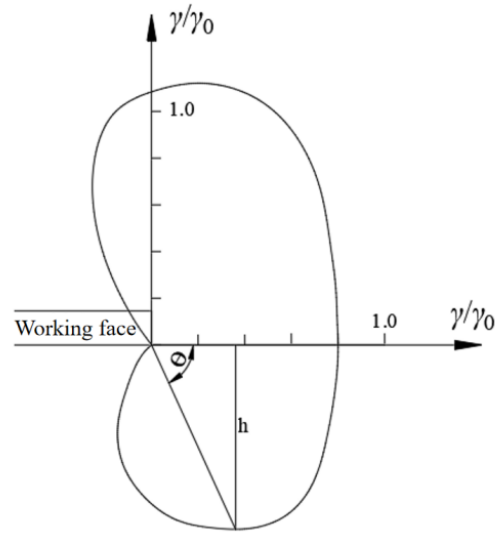
Figure 9. Surrounding rock yield failure of working face.